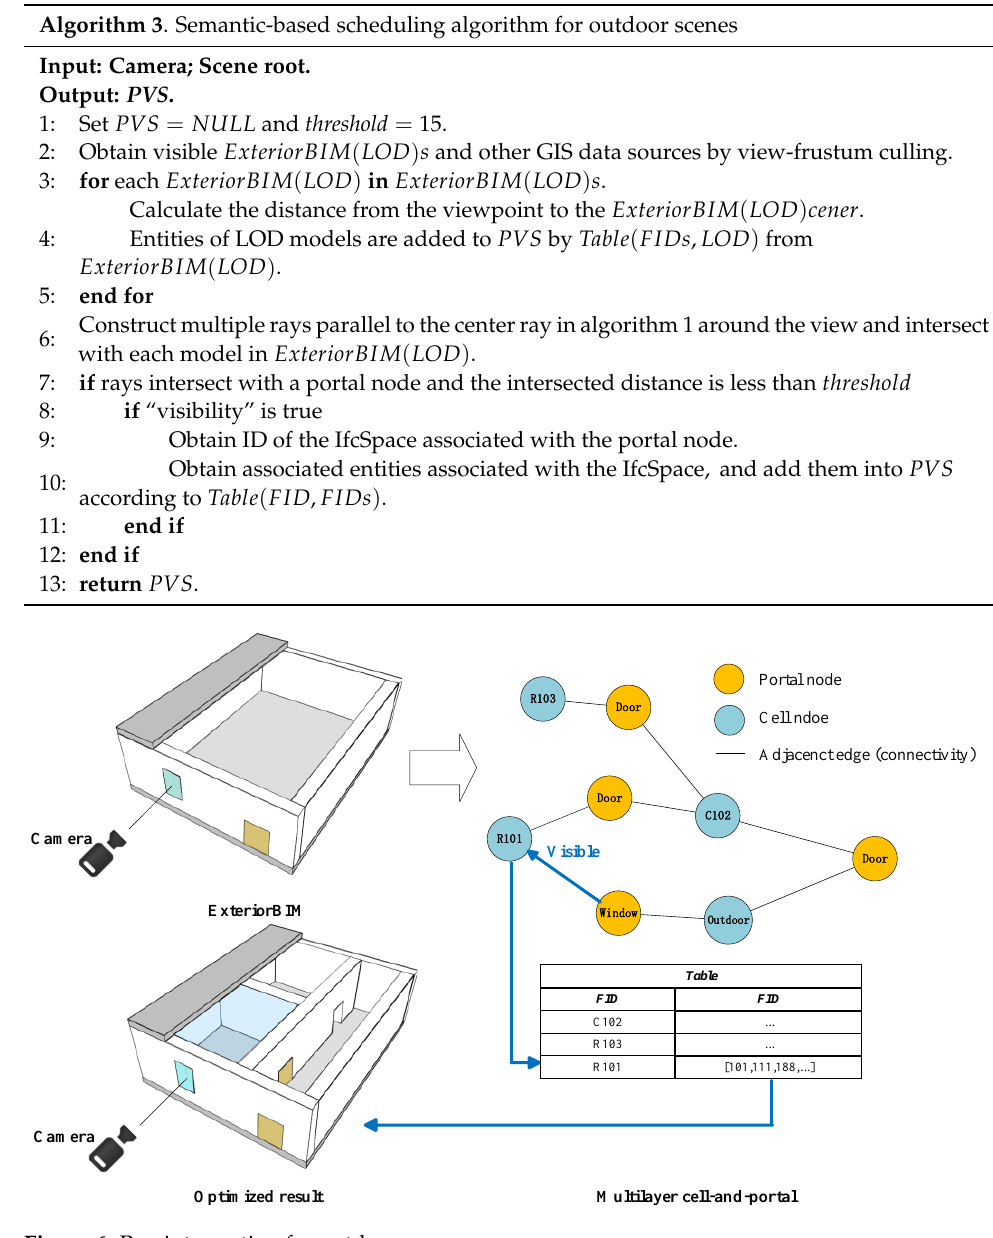
Figure 6. Ray intersection for outdoor scenes. Algorithm 3 . Semantic-based scheduling algorithm for outdoor scenes